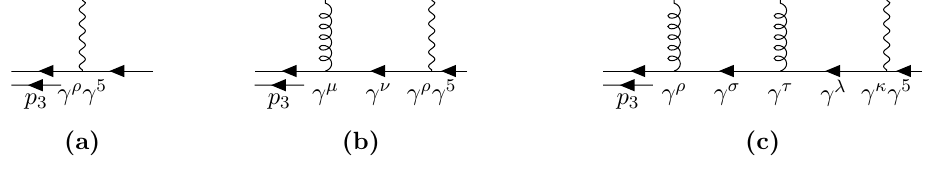
Figure 5 . The relevant (cid:13) matrix structures for A (0 ; 2) ; AA diagrams, (cid:12)gure 5b corresponds to box diagrams and (cid:12)gure 5c corresponds to pentagon diagrams.